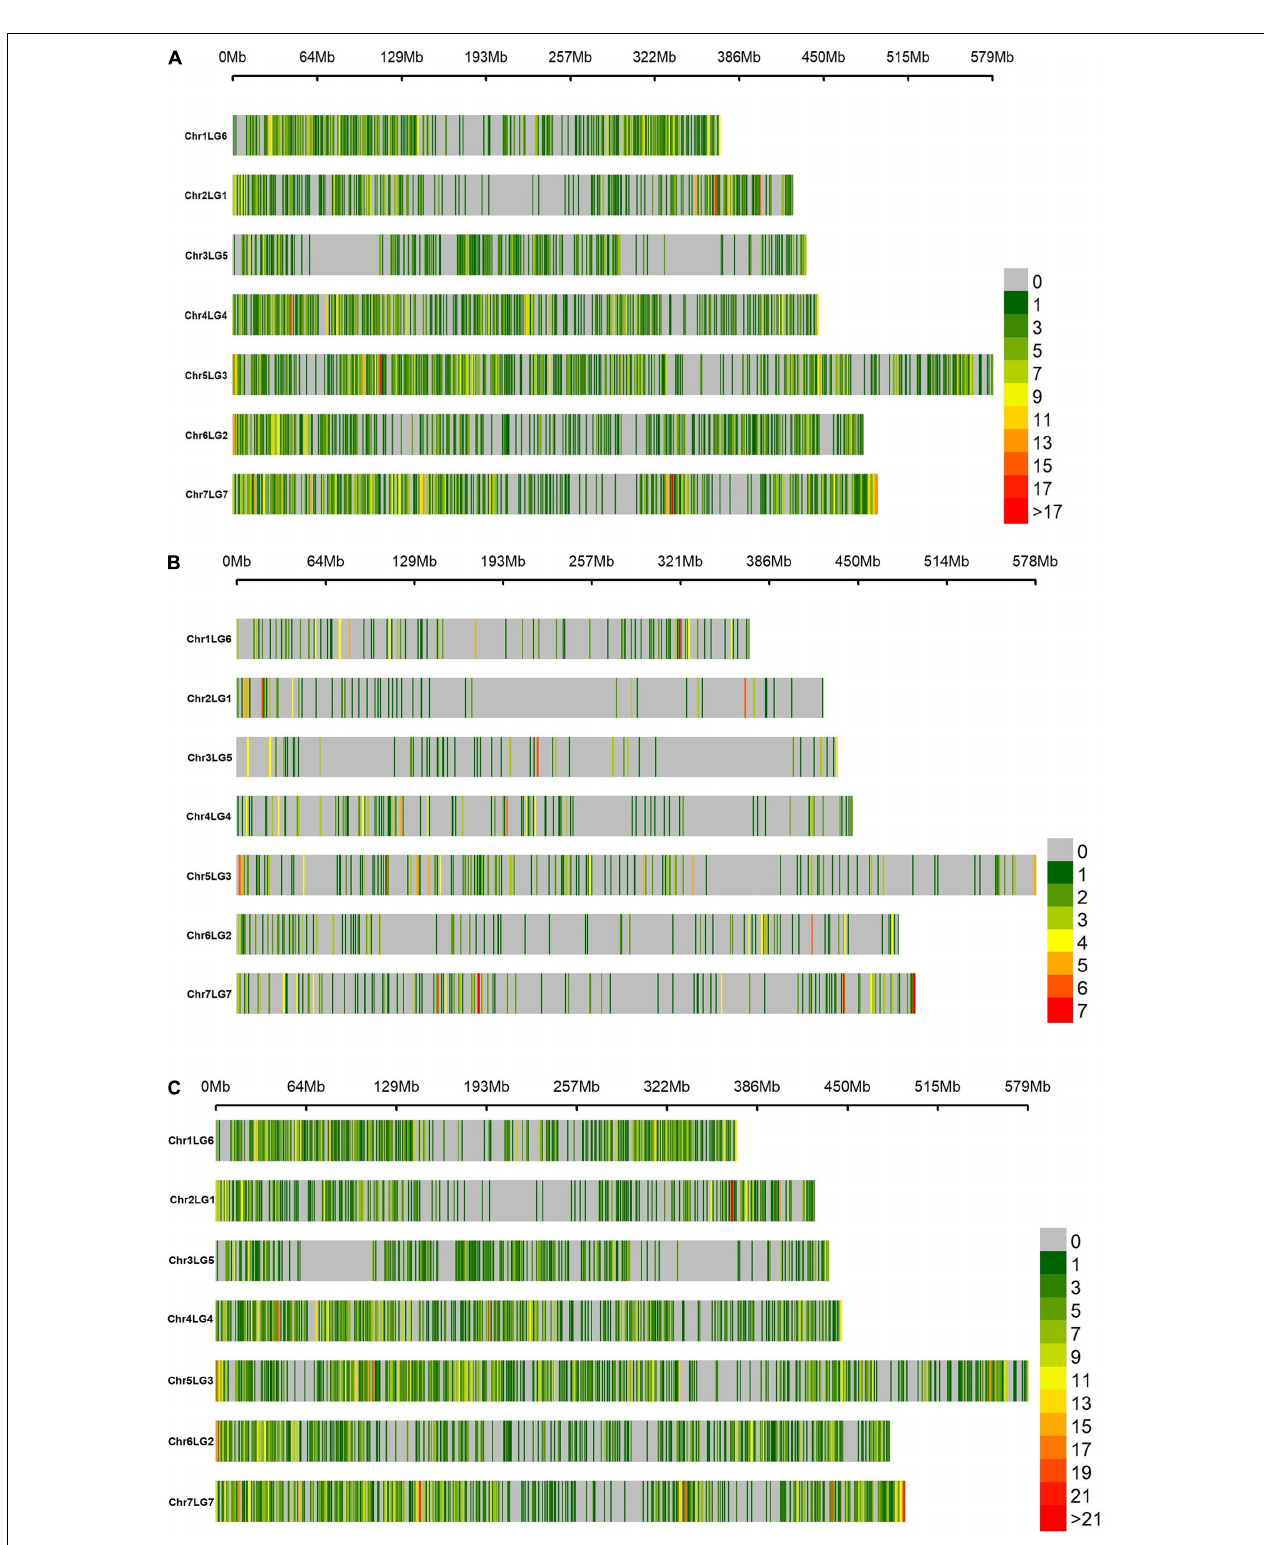
FIGURE 1 | Density distribution of single nucleotide polymorphism (SNP) markers in a 1 Mbp window size across the seven chromosomes of wrinkled vining pea generated from (A) diversity arrays technology sequencing (DArTseq), (B) genotyping-by-sequencing (GBS), and (C) DArTseq and GBS combined. The assigned numbers of chromosomes and linkage groups are according to Neumann et al.